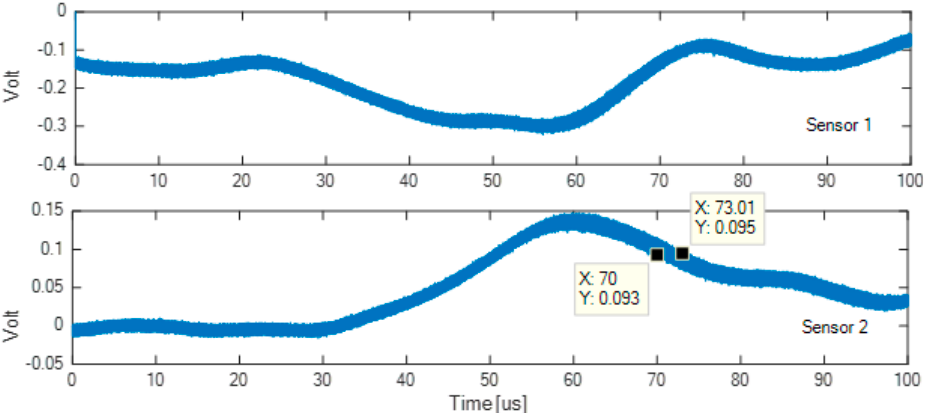
Figure 3. Test on the signal acquisition jitter: acquisition of 100 impacts in the same point of the aluminum test sample, with sensors 1 and 2 shown in Figure 1.